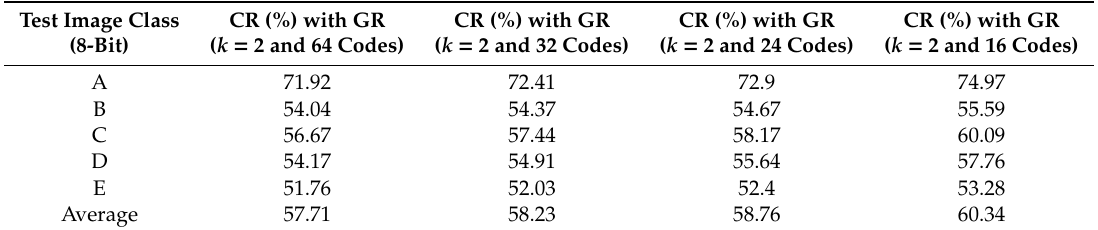
Table 7. CR comparison with Golomb–Rice (GR) coding with di ff erent codewords for 8-bit images.